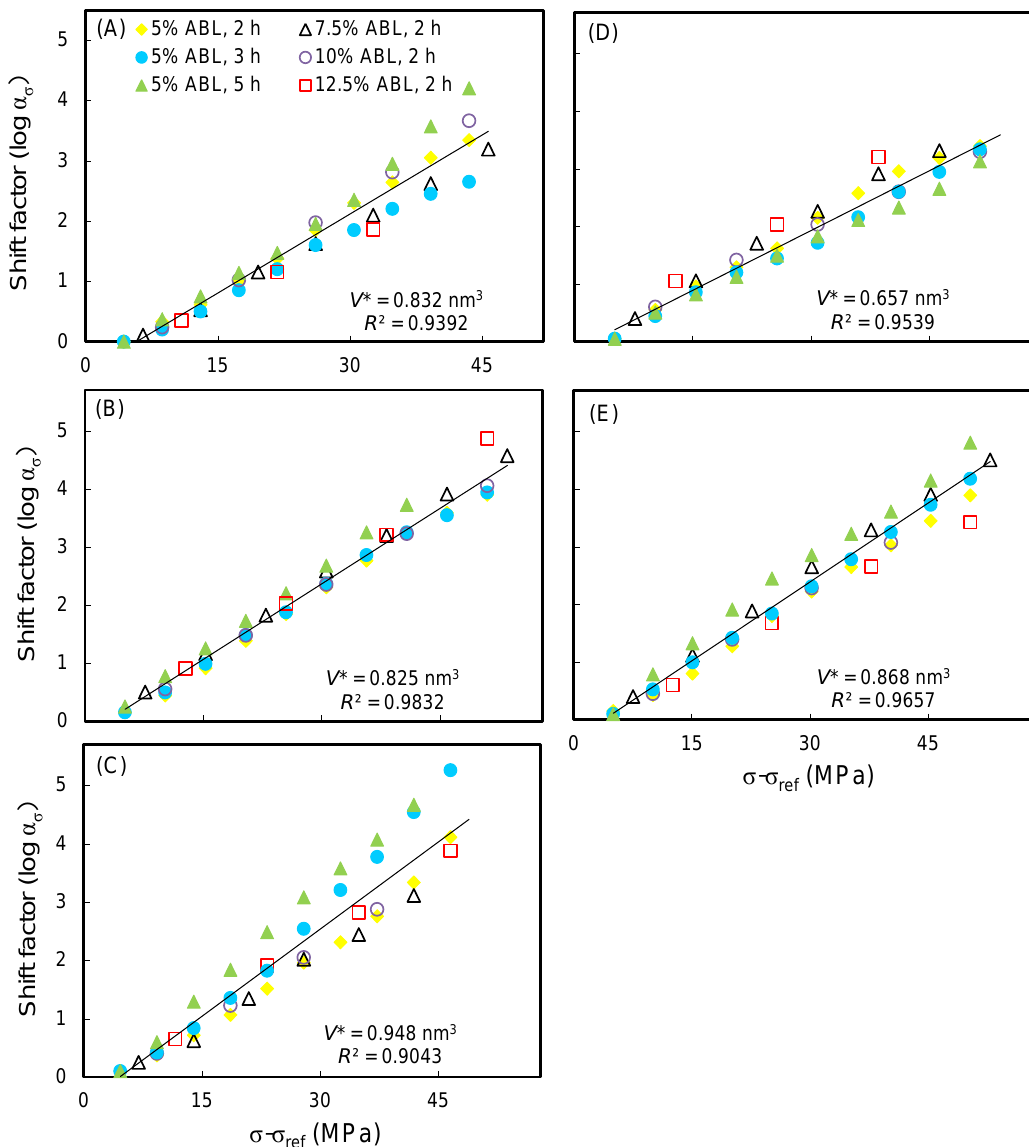
Figure 4. Typical Eyring plots of ( A ) wood, and WICs prepared from ( B ) MTMOS, ( C ) MTEOS, ( D ) TEOS, and ( E ) TTIP at a reference load of 30% ABL.